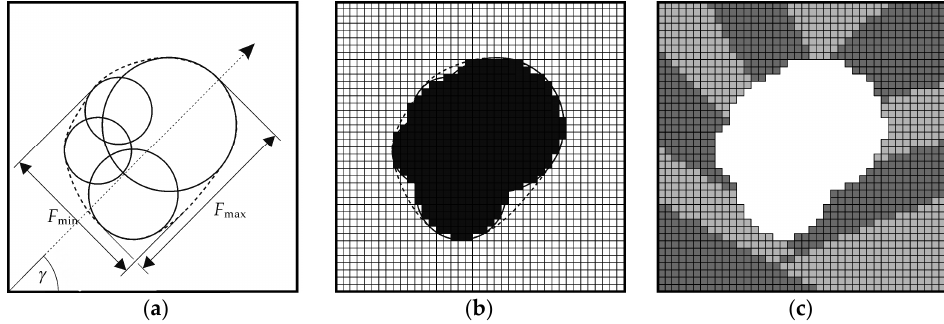
Figure 4. Modeling of pores with convex boundaries (schematic): ( a ) Approximation of actual pore geometry (dashed line) with Feret diameters, F min and F max , and Feret angle γ , by placing overlapping spheres in a predefined bounding box; ( b ) Grid discretization of the sphere domain; ( c ) Elimination of the corresponding elements from the voxel mesh of the grain microstructure.